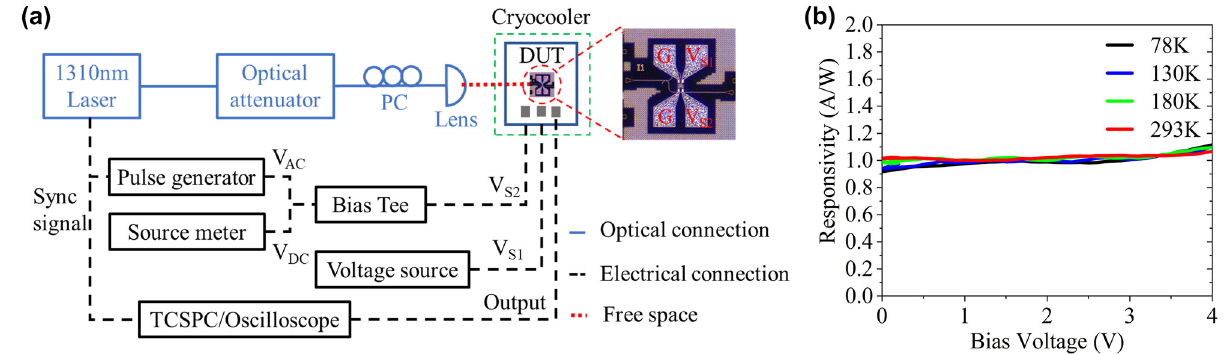
Figure 3: Experimental setup for the measurement. (a) Experimental setup for characterizing the performances of the three-terminal SACM SPAD. V and V are generated from a source meter and a pulse generator, respectively. V AC optical fiber connections, the black dotted lines denote cables for electrical connections and the red dotted line denotes the free-space optical connection. PC, polarization controller; DUT, device under test; TCSPC, time-correlated single photon counting. (b) The responsivity of the standard PIN detector at different temperatures.